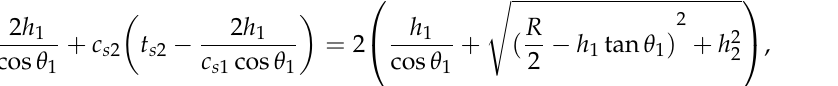
The thickness of the second layer can be estimated once the first layer’s thickness and the shear wave velocities in all layers are known. Following the flight time of superposition shear waves at the center point, the predicted thickness should also be: